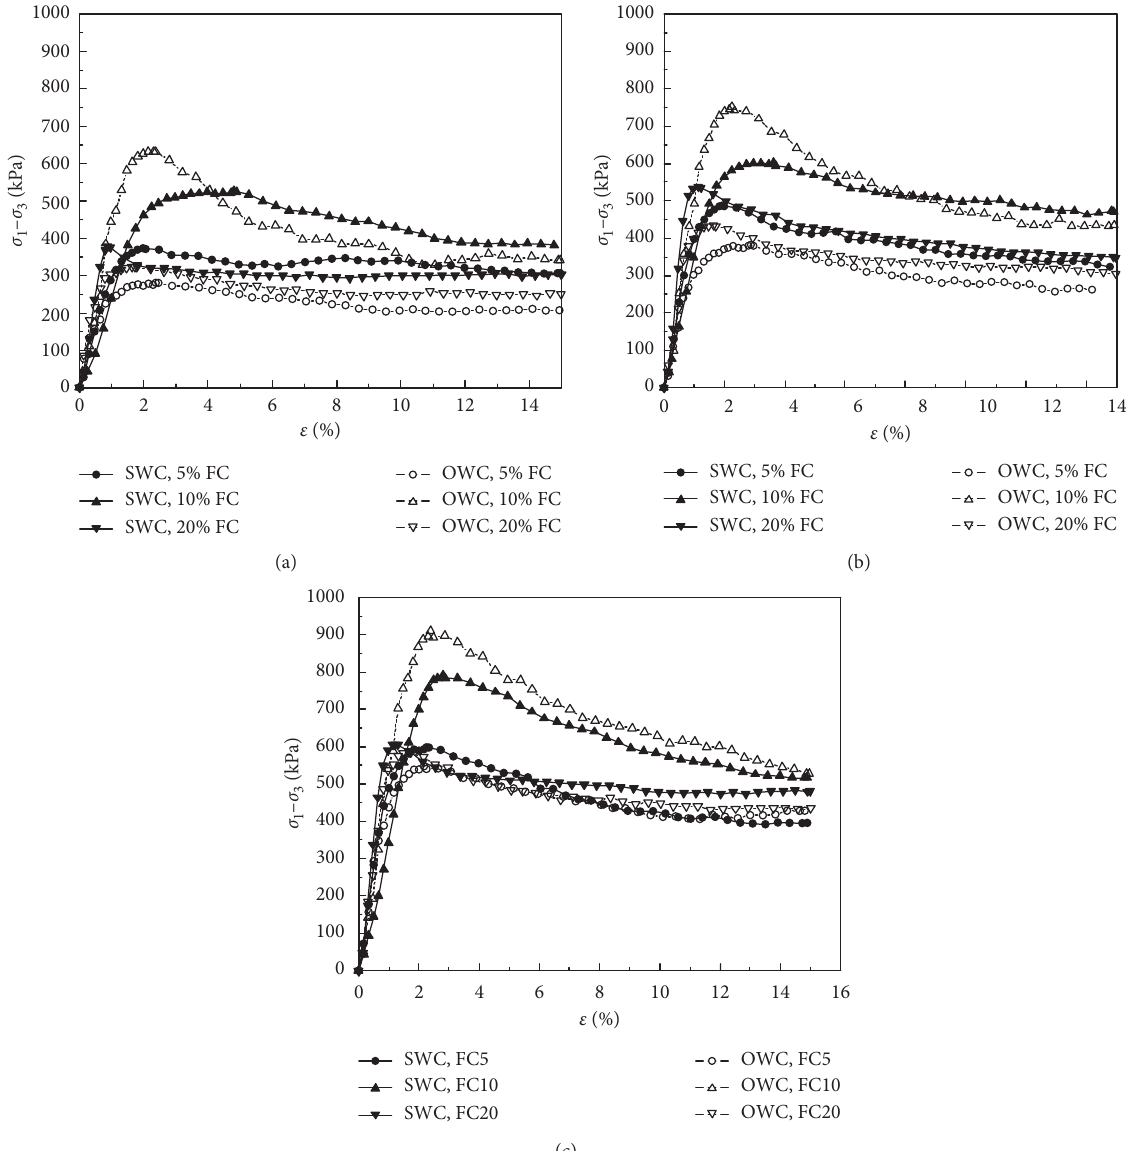
Figure 7: The relationship between deviatoric stress and axial strain for graded gravels under the confining pressure of (a) 20kPa, (b) 40kPa, and (c)